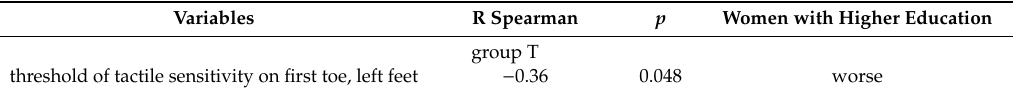
Table 6. Statistically significant relationships between the threshold sensitivity test and the level of education in group